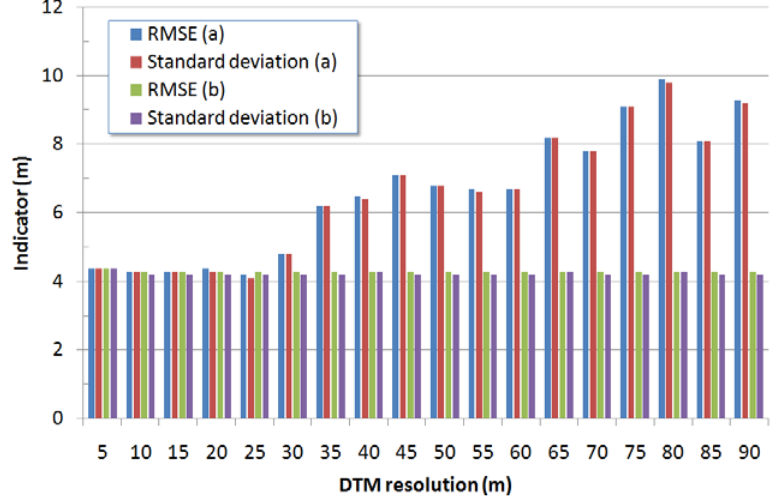
Figure 4. Summary of results for the Cartosat-1 multi-resolution DSMs generated over Salon de Provence test site. Comparison with respect to the high-resolution reference DSM (reference DSM-Cartosat-1 DSM): (a) for DSMs generated at the desired resolution directly from the Cartosat-1 images; (b) for DSMs generated by downsampling the 5m resolution Cartosat-1 DSM. All values refer to a comparison over the whole test site.